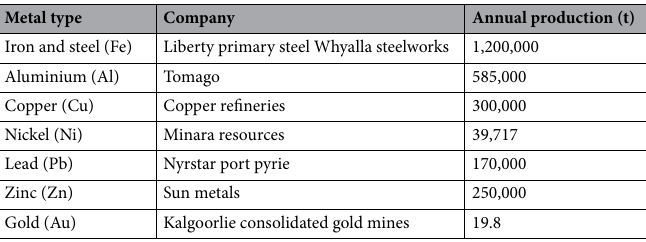
Table 1. Selected companies based in Australia which produce